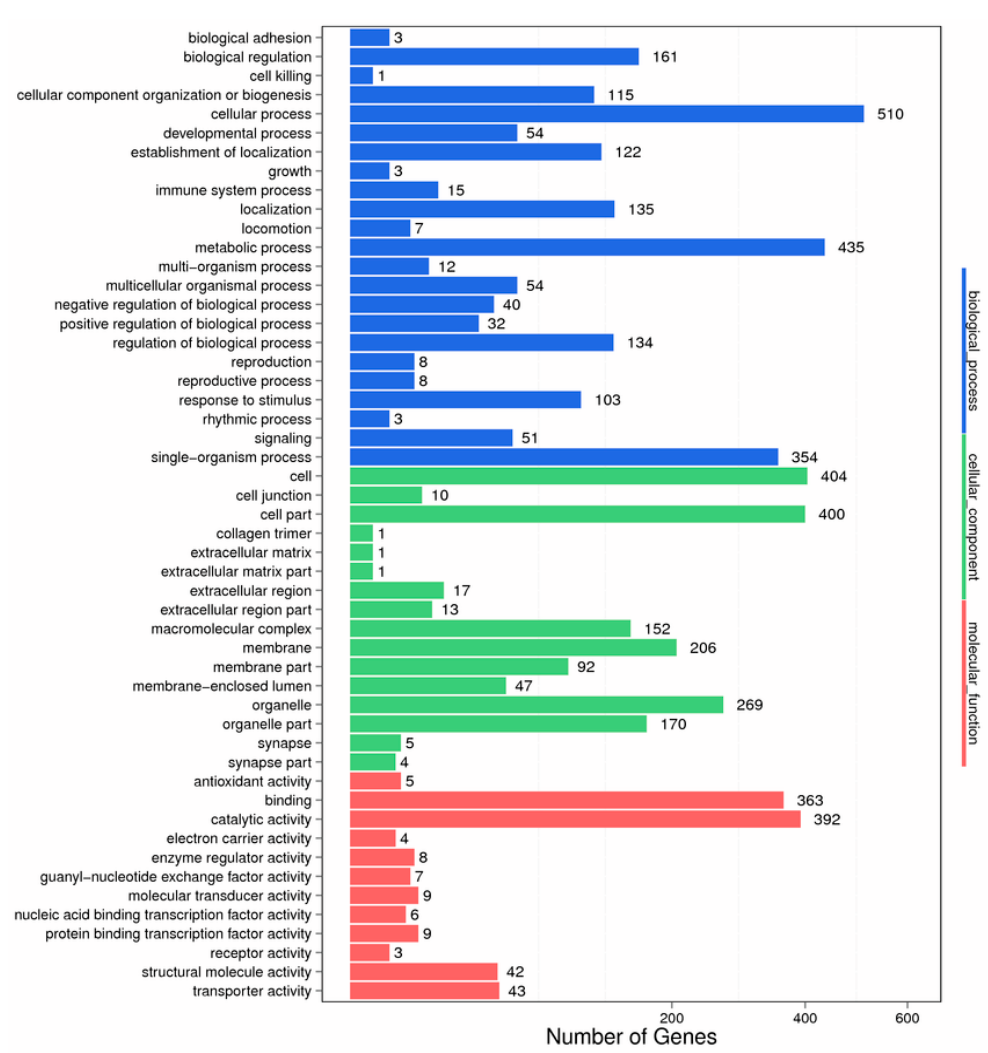
Figure 5. GO classification of the differentially expressed genes. The x -axis represents the GO term.